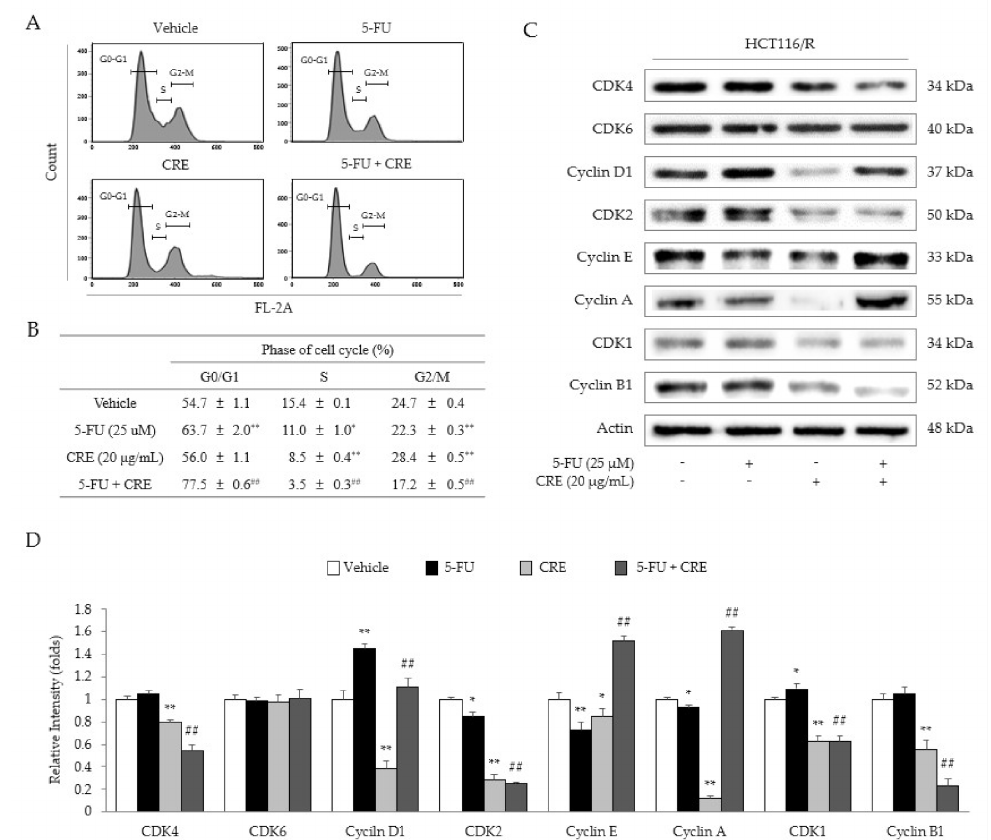
Figure 4. Cell cycle arrest is induced by co-treatment with 5-FU and CRE. The cell cycle distribution was analyzed in HCT116/R cells treated with CRE or 5-FU ( A ), and the relative percentages are indicated ( B ). Cell cycle-related protein expression levels ( C ) and the corresponding intensities were quantified ( D ). Data are expressed as the mean ± SD ( n = 3) values. * p < 0.05 and ** p < 0.01, as compared to vehicle-treated cells. ## p < 0.01 compared to 5-FU-treated HCT116/R